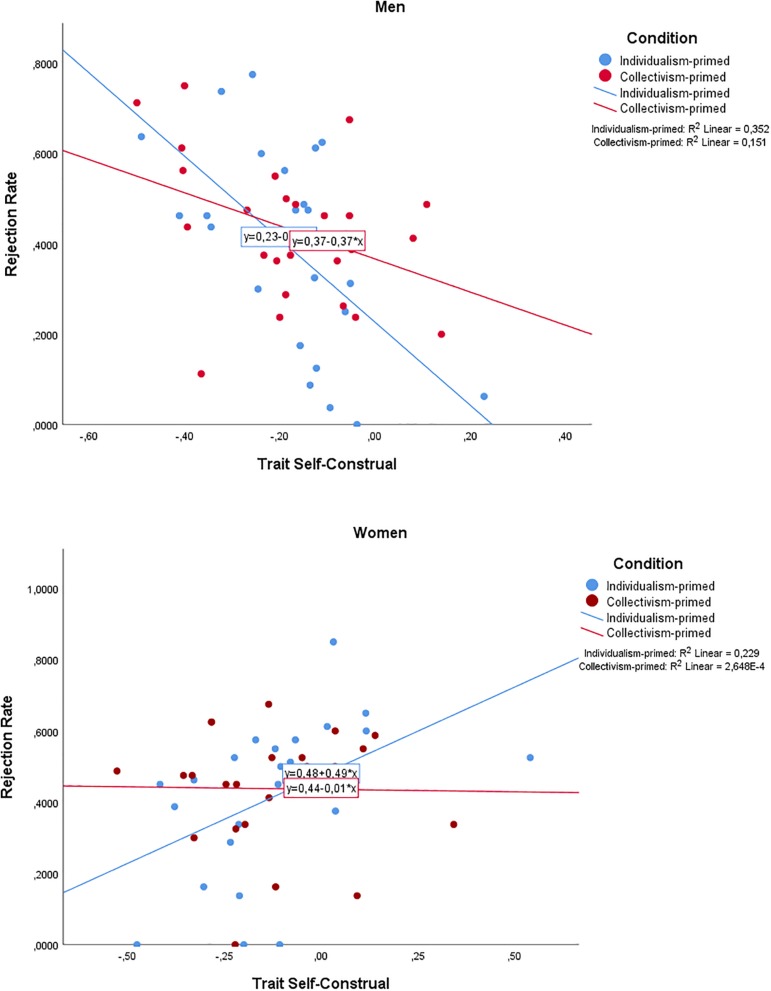
Three-way interaction between Gender, Trait Self-Construal (TSC), and Priming Conditions broken down by Gender. For independent-primed men, a lower value of TSC resulted in higher rejection. For women, a higher value of TSC resulted in greater rejection rates. There were no differences in the collectivistic priming condition. TSC is mean-centered.